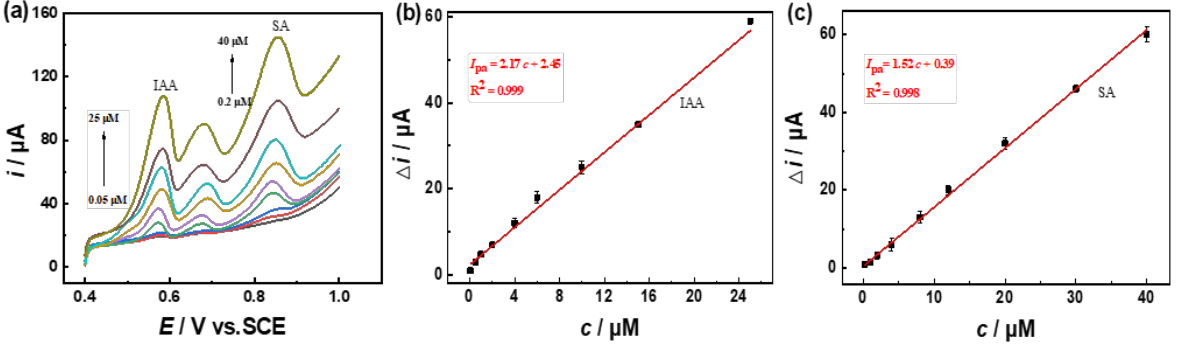
Figure 11. LSV ( a ) curves of PPRONPs − CDs − MWCNTs/GCE in 0.1 M PBS (pH = 7.0) containing different concentrations of IAA and SA. The linear correlation curve of peak currents vs. concentrations of IAA ( b ) and SA ( c ), respectively. Table 2. Comparison of typical modified electrodes for determination of IAA and SA.